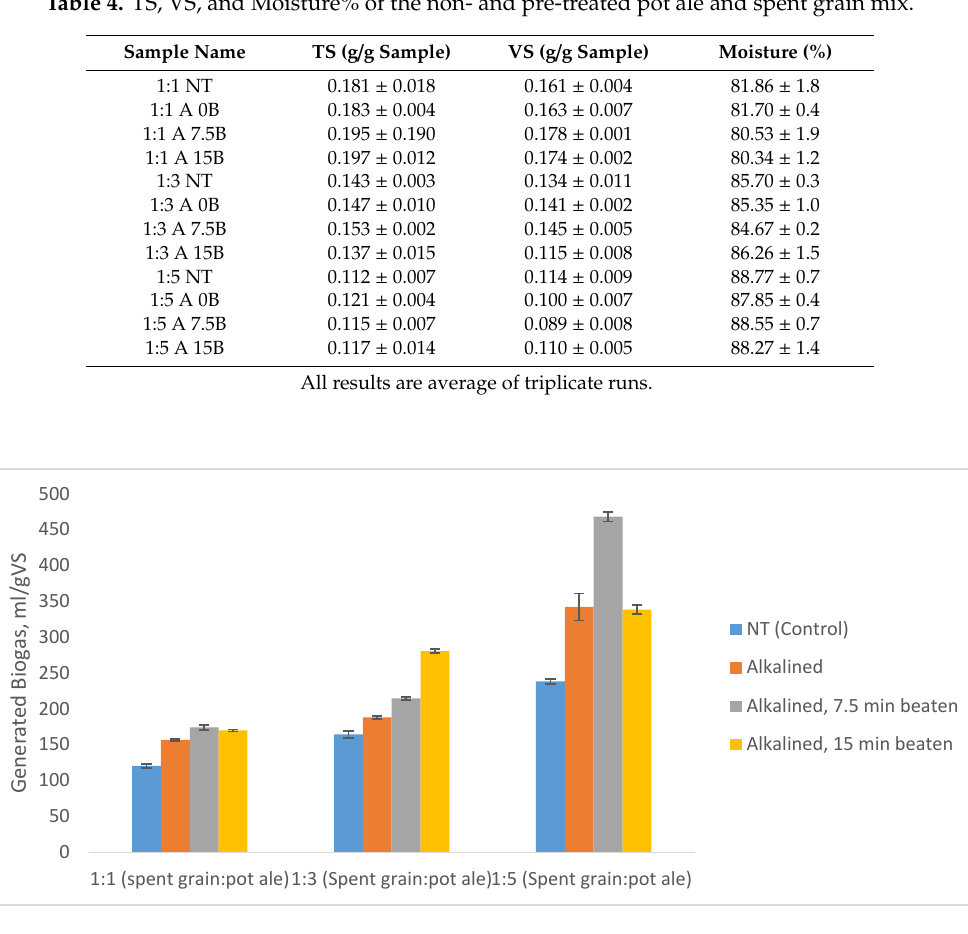
Table 4. TS, VS, and Moisture% of the non- and pre-treated pot ale and spent grain mix